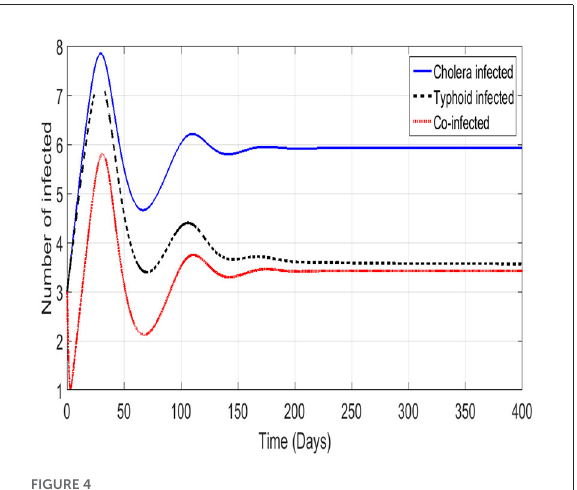
FIGURE3 The contour map of the basic reproduction number, R 0 , as a function of the typhoid recovery rate, ǫ t , and the cholera recovery rate, ǫ c .